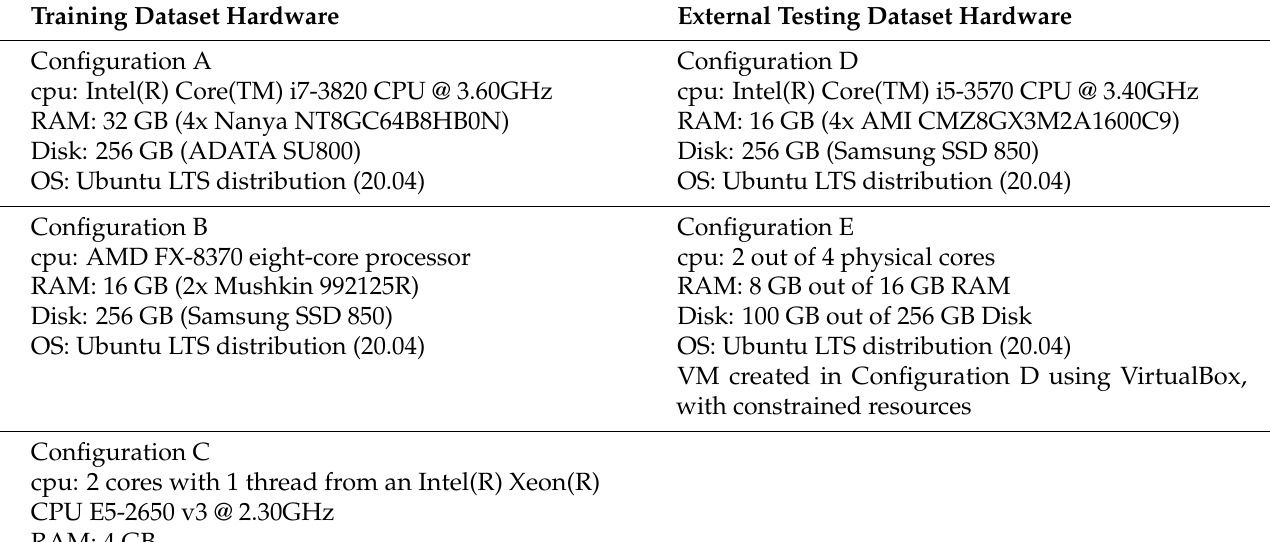
Table 2. Hardware configuration of the testing and training datasets.